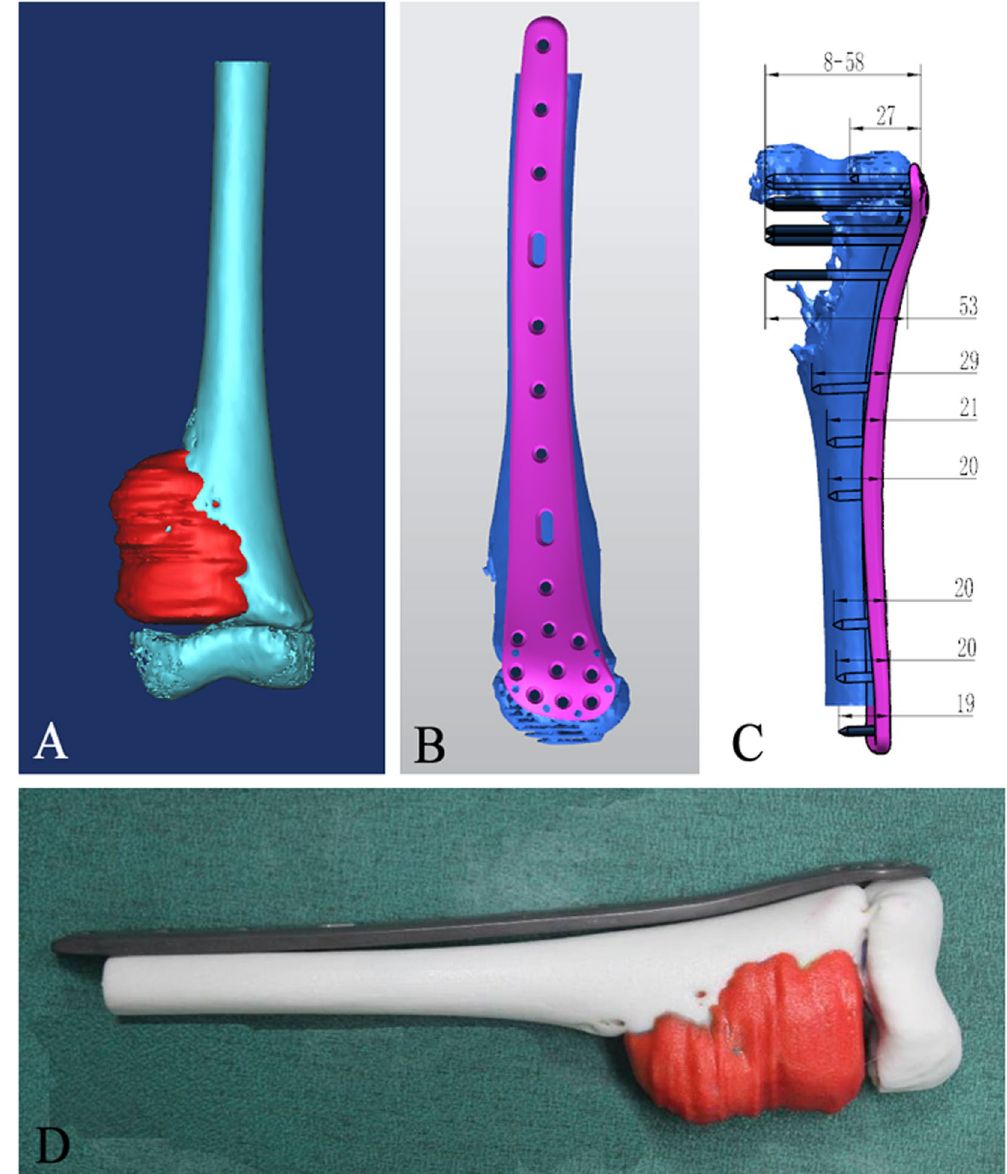
Mimics software according to the merged CT-MR data. ( B ) The 3D model of the tumorous bone is matched with a personalized titanium plate model (pink) using UG software. ( C ) The resultant 3D model is filled with screws in order to show the required number as well as the location and lengths of the screws that will be used during the operation. ( D ) The 3D printed tumorous bone model is matched with a fabricated personalized titanium